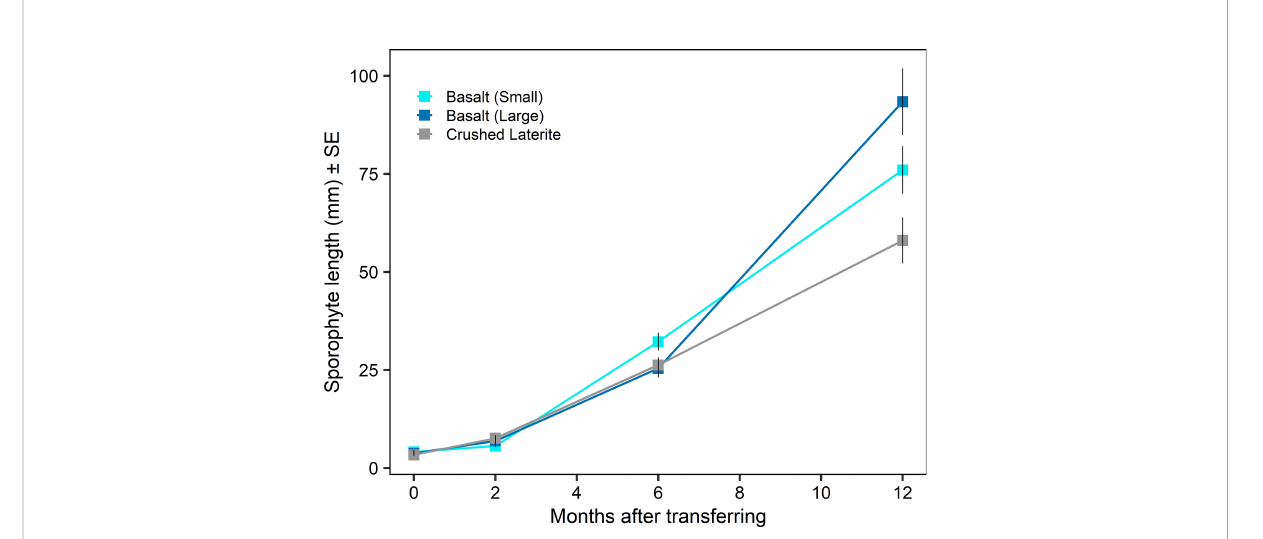
FIGURE 4 Sporophyte length (mean ± SE) on green gravel over time after transferring into aquarium tanks. Colours refer to the type of substrata.